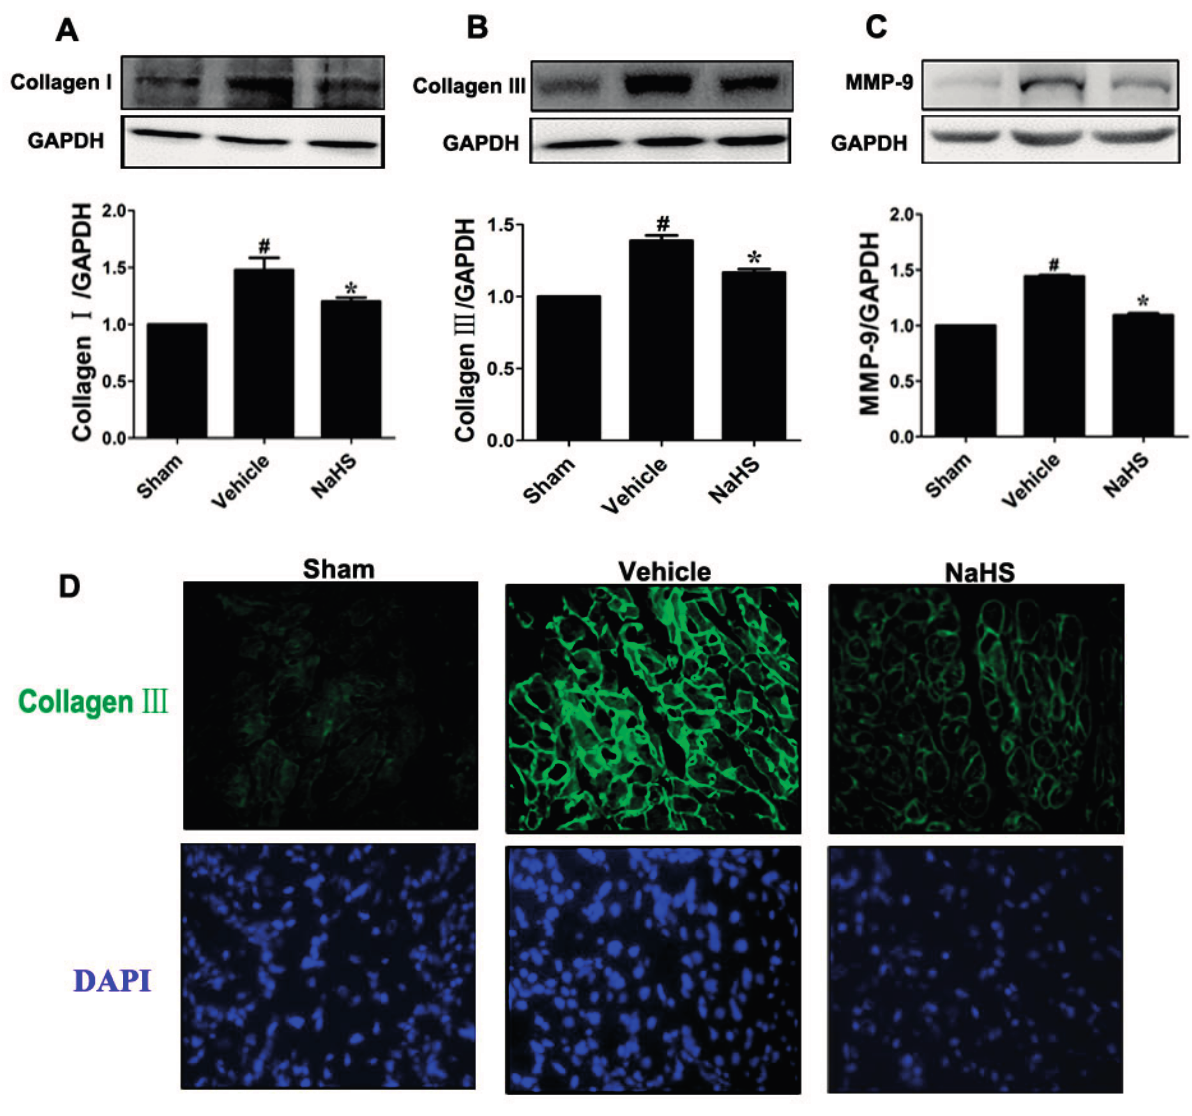
Figure 2. NaHS mitigated type I and III collagen as well as matrix metalloproteinases-9 (MMP-9) expression. Western blot for ( A ) type I collagen; ( B ) type III collagen; and ( C ) MMP-9 expression. Bar graphs showed quantitative analysis of type I collagen, type III collagen, and MMP-9; GAPDH was used as loading control. Representative photomicrographs showing ( D ) type III collagen in the border zone of infarcted myocardium detected by fluorescence microscopy (×400 magnification). # p < 0.05 vs . sham-operated group; * p < 0.05 vs . vehicle-treated group; n =